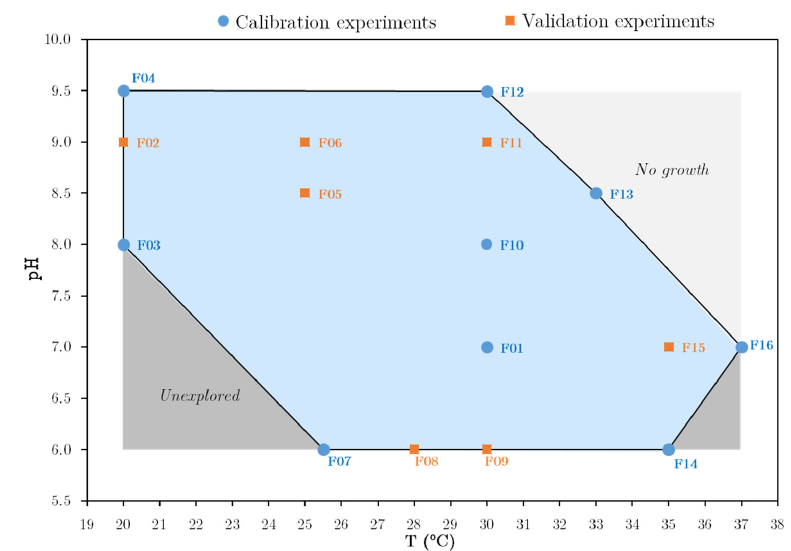
Figure 2. Operating conditions of C. maltaromaticum CNCM I-3298 fermentation experiments. Fermentation durations varied between 20 h and 45 h, and the initial conditions were: